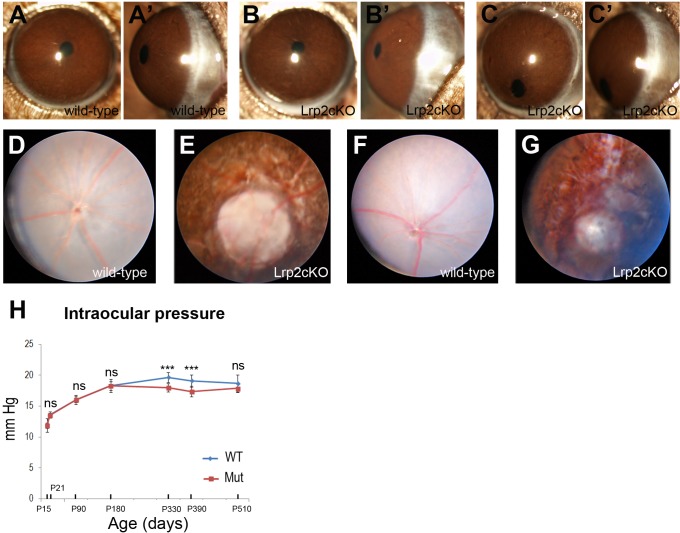
Opthalmological evaluation of control and mutant mice.Similar gross morphology of the anterior segment in control (A, A’) and Lrp2
FoxG1.cre-KO mutant littermates at P90 (B, B’). In some cases pupillary ectopia was observed in the mutants (C, C’). Fundus photographs of control (D, F) and mutant eyes (E, G) at P60 (D, E) and P180 (F, G) respectively show chorioretinal atrophy and peripapillary staphyloma. (H) Comparisons of intraocular pressure between control and mutant littermates at the indicated postnatal ages. Two-way ANOVA post hoc Tukey test was used, ***P<0.001, ns: not statistically significant, values are mean ± SEM of 10 animals per age and genotype.